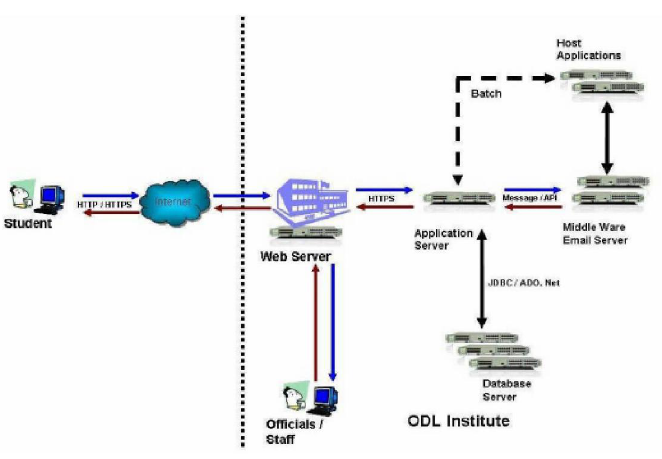
Fig. 4. Web infrastructure architecture for integrated information system based DSS in an